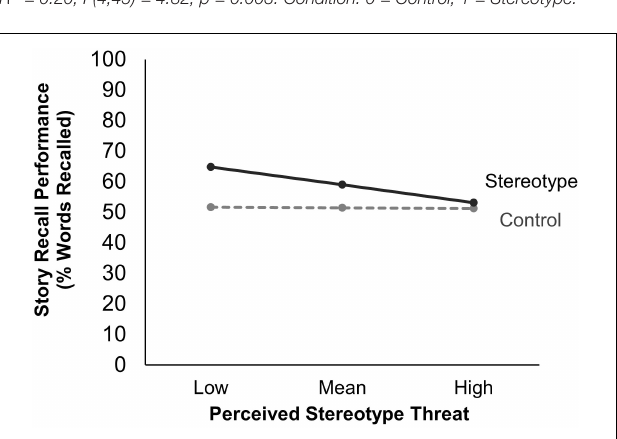
FIGURE 4 | Story recall performance by condition and perceived stereotype threat. Perceived threat is mean centered. Low is defined as –1 SD (0.89), and High is defined as +1 SD